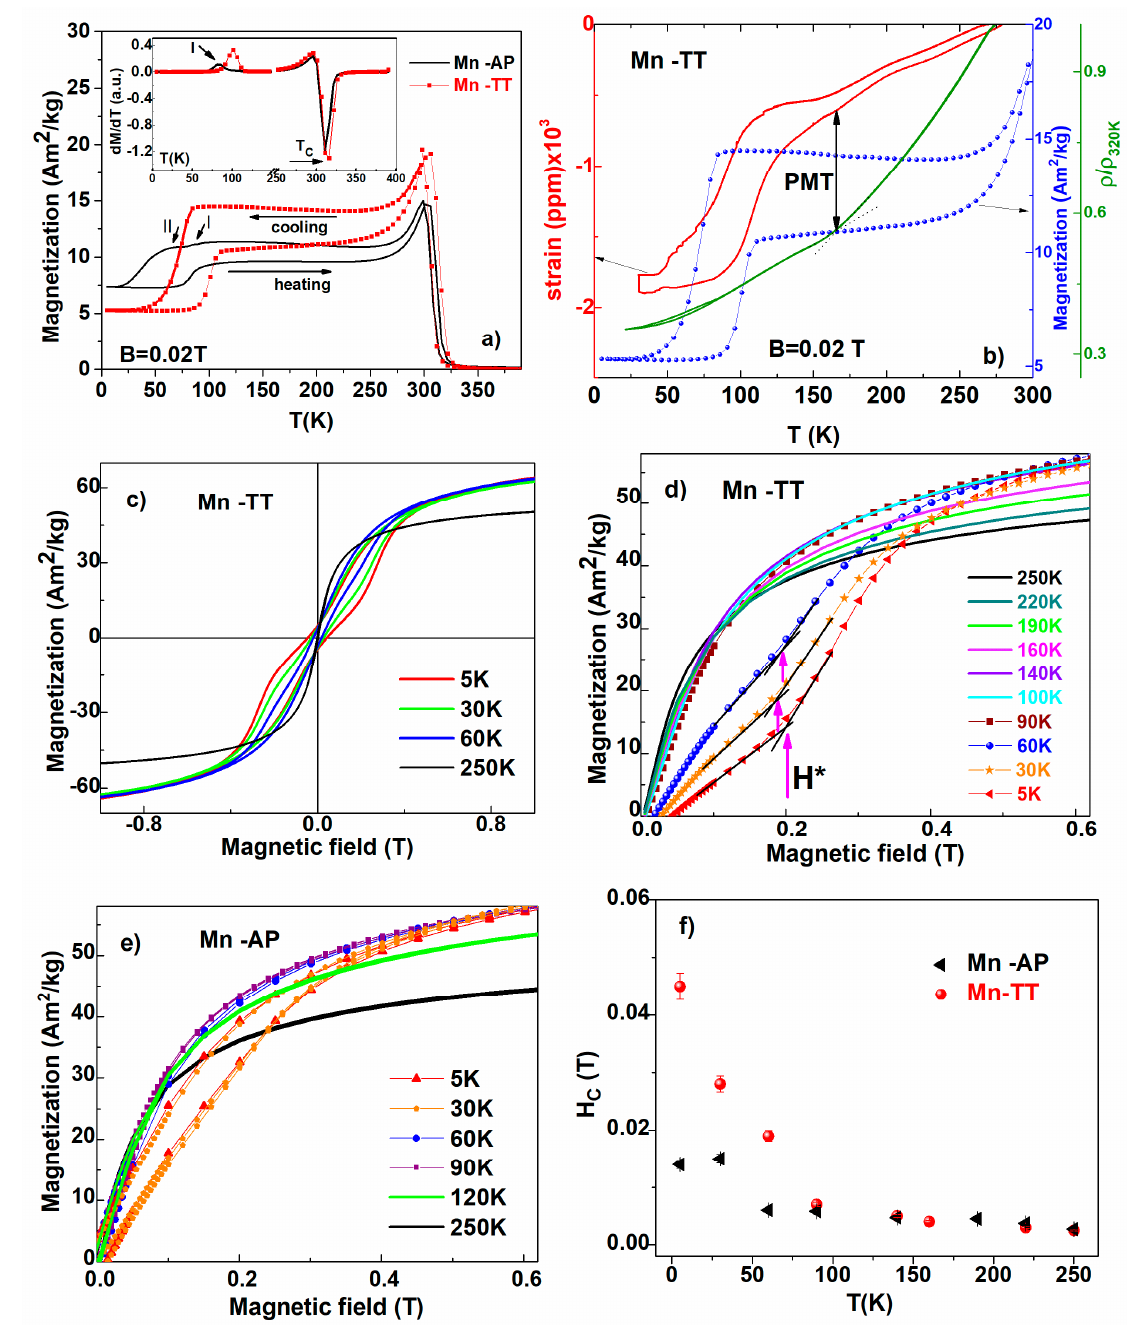
Figure 3. ( a ) The temperature dependence of magnetization on Mn-AP and Mn-TT ribbons at low temperature in 0.02 T applied magnetic field; Inset: The first derivative of magnetization dM/dT; ( b ) The thermo-magnetic, thermo-resistivity and thermal expansion measurements to identify MT interval and also the value of the PMT start temperature (at 190 K) for the Mn-TT sample; ( c ) Hysteresis loops for Mn-TT ribbons; ( d ) isothermal dependences of magnetization versus applied field for Mn-AP sample. The critical field H* is 0.29 T at 5 K and 0.22 T at 60 K; ( e ) magnetization dependences on the applied field for Mn-TT ribbons. ( f ) The temperature dependence of the coercive field.